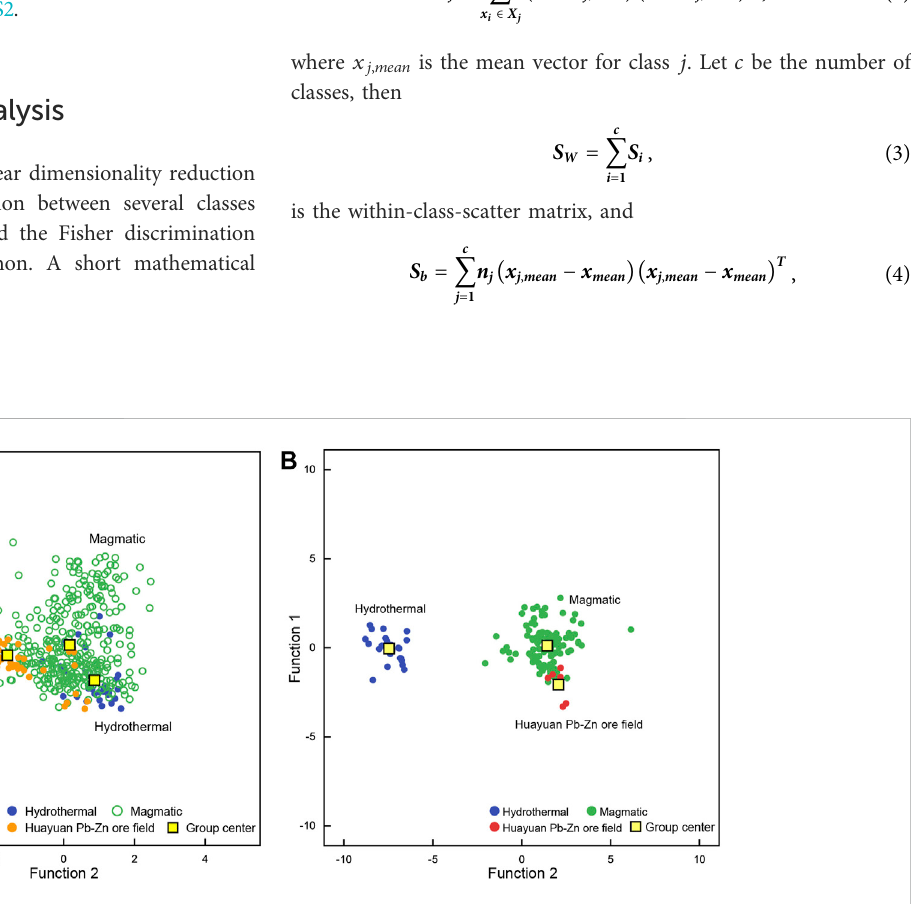
FIGURE 7 Classi fi cation plots based on (A) major element and (B) trace element